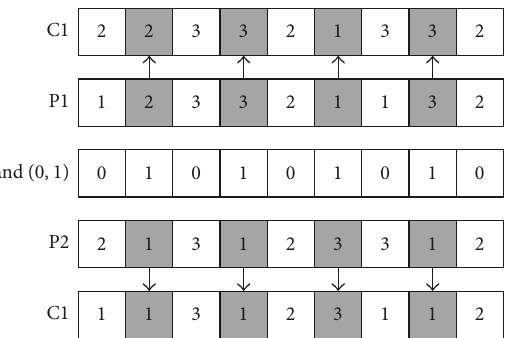
Figure 6: Crossover operation for machine part.